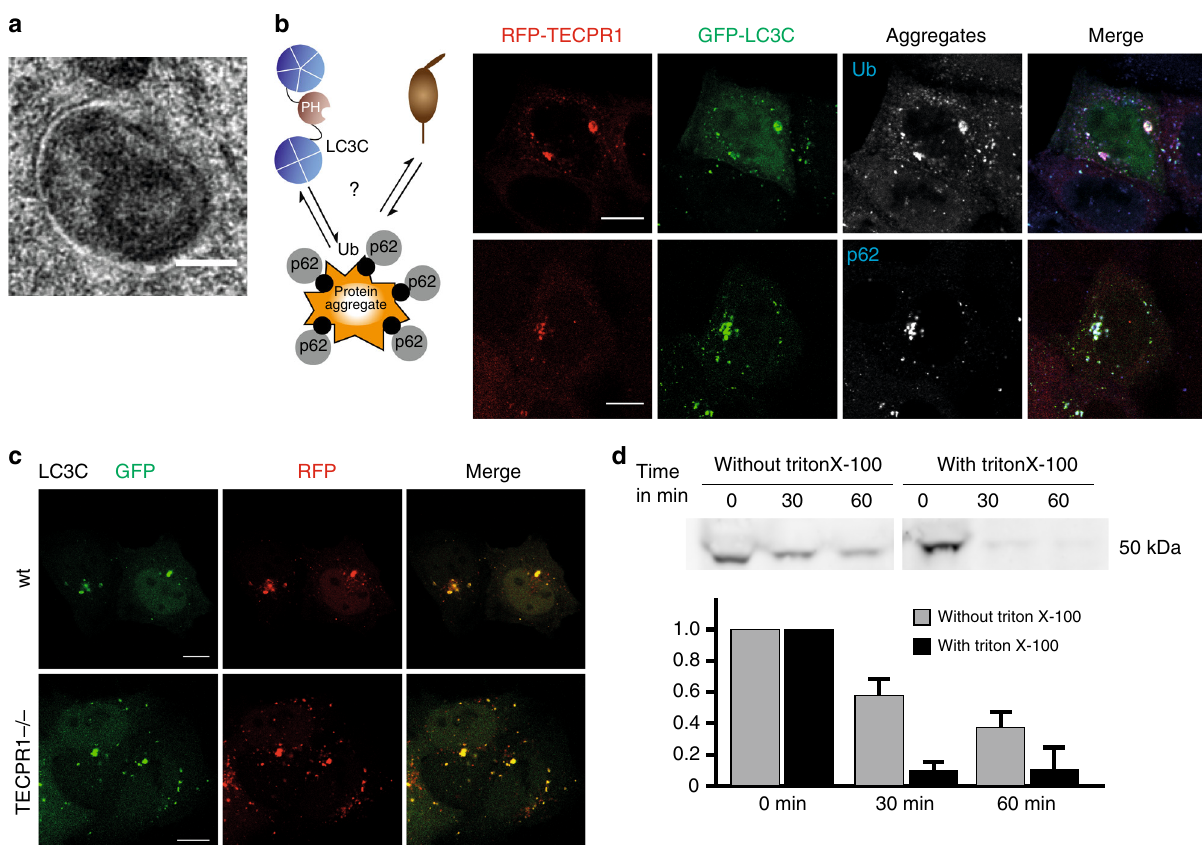
Fig. 6 TECPR1 and LC3C coordinate targeting of aggregates to lysosomes. a Correlative light electron micrograph of HeLa cells that expressed RFP-LC3C. The electron micrograph shows a 70 nm section. RFP-LC3C fl uorescence correlated with a double membrane structure that surrounds electron-dense amorphous material. Scale bar, 200 nm. b Confocal images of puromycin-treated TECPR1 KO cells that co-expressed RFP-TECPR1 and GFP-LC3C and that were immunostained for Ub or p62. Scale bars, 10 µ m. c Confocal images of puromycin-treated wild-type (wt) and TECPR1 KO cells expressing RFP-GFP- LC3C. Most structures displayed GFP and RFP fl uorescence. Scale bars, 10 µ m. d Proteinase K protection assay of GFP-LC3C transfected HeLa cells. Immunoblotting was performed using an anti-GFP antibody. Lysates were incubated with Proteinase K for indicted times in the absence or presence of Triton X-100. The chart shows quanti fi cation of three independent experiments (mean ± SD). Source data are provided as a Source Data fi